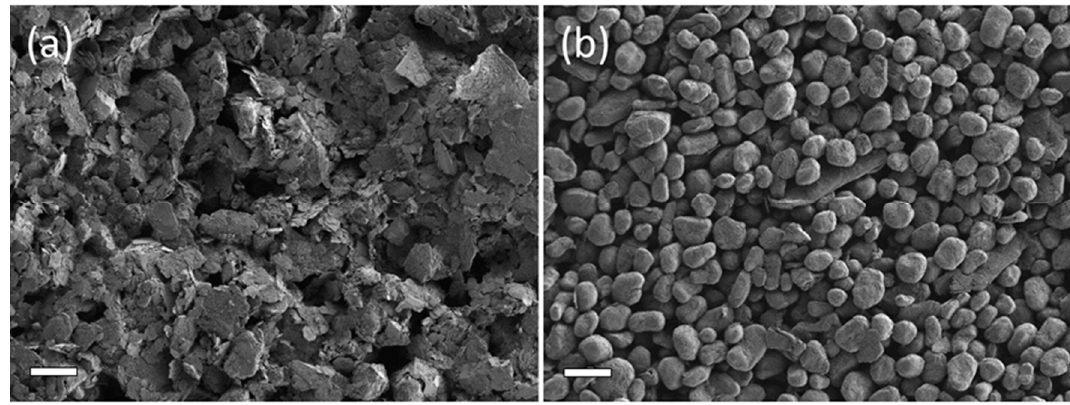
Figure 8. SEM micrographs of graphites: ( a ) flake-shaped MAG-D (scale bar: 20 µm); ( b ) potato-shaped SGB 10 MOZ V12 (scale bar: 20 µm).